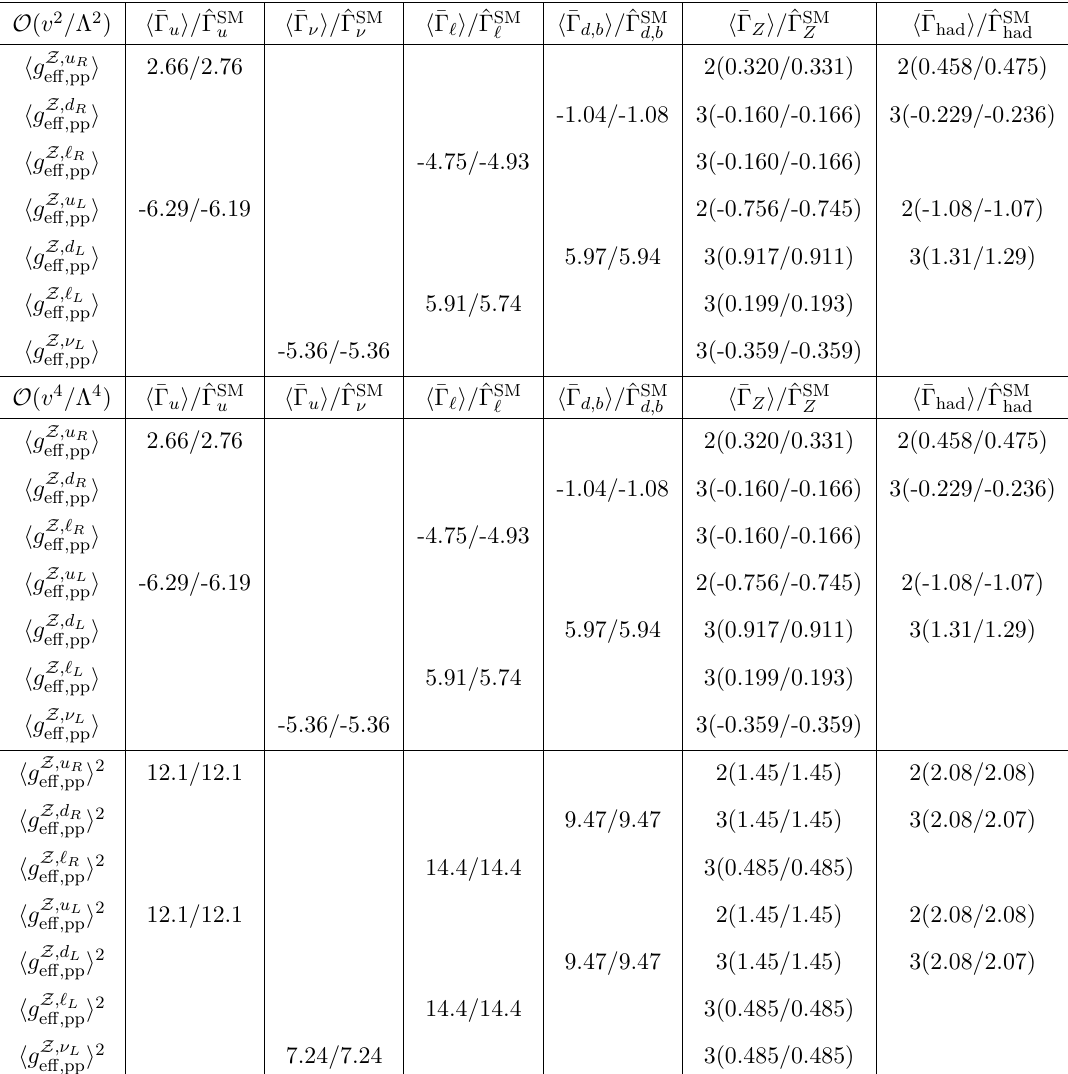
Table 3 . Dependence of the partial widths on the effective couplings, scaled to the SM prediction of the partial width. For the columns ¯Γ ‘ , ¯Γ u , ¯Γ d,b the individual partial widths are reported.